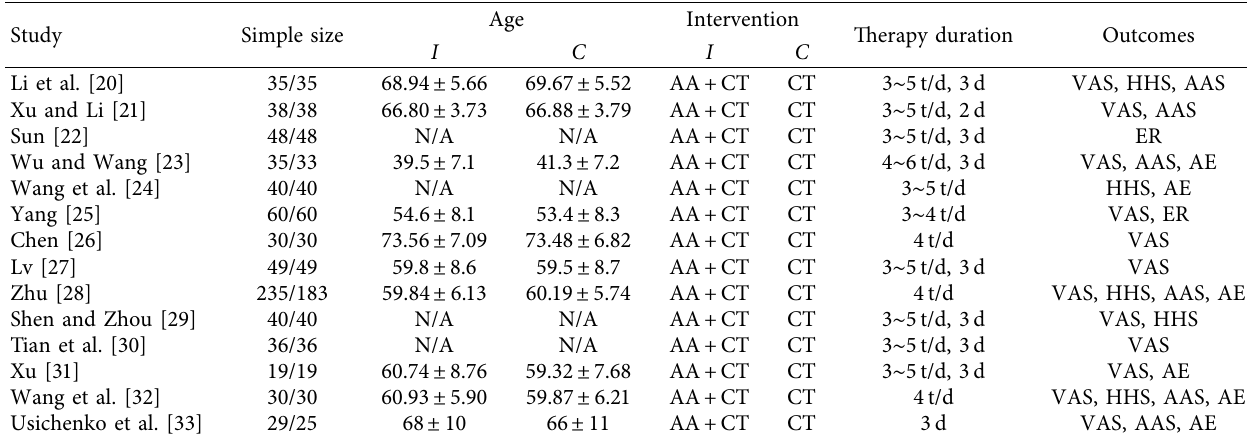
Figure 1: Literature screening fowchart. Table 1: Characteristics of the included